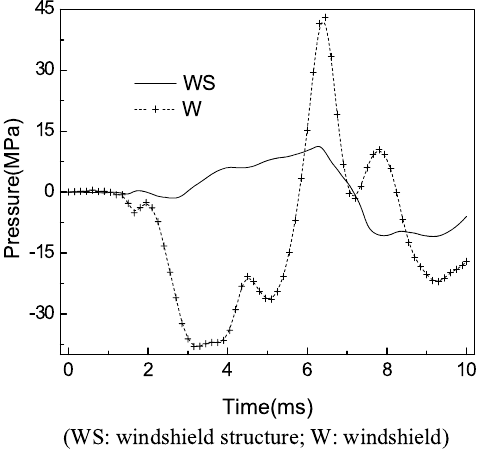
Fig. 28. Time history of pressure at vertex of camber line on outer surface of